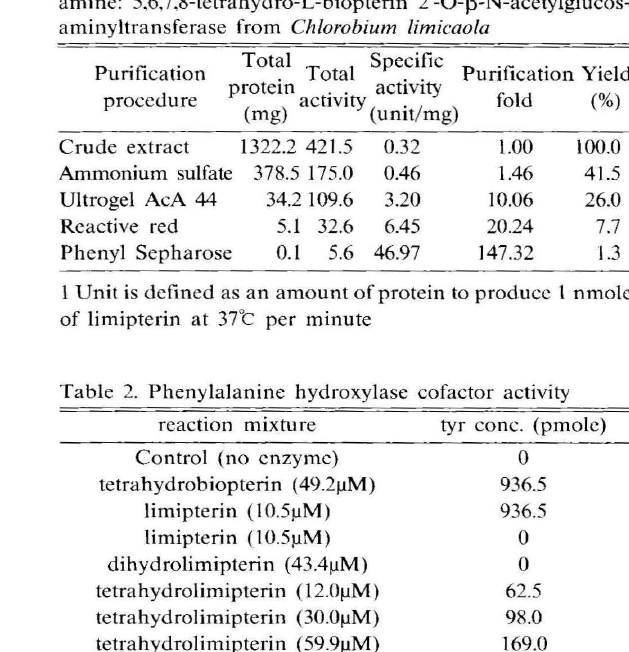
Table 2. Phenylalanine hydroxylase cofactor